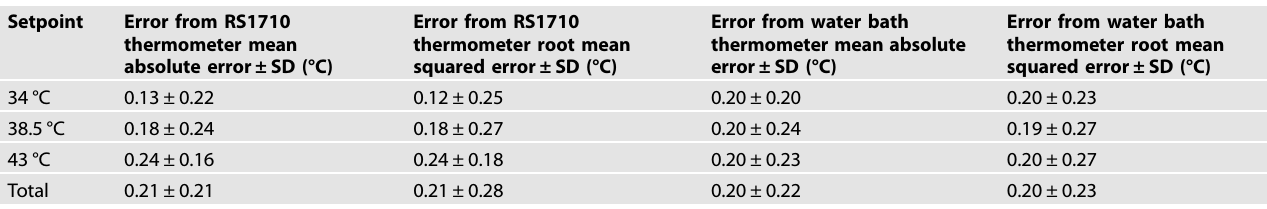
Fig. 4 Water bath temperature readings at different setpoints for each temperature sensor. There are two reference sensors (Water bath and RS1710) and one sensor embedded in the mouthguard. All data were synchronized during collection. The IQR represents the interquartile range for the mouthguard data. Table 1. Steady-state error in temperature